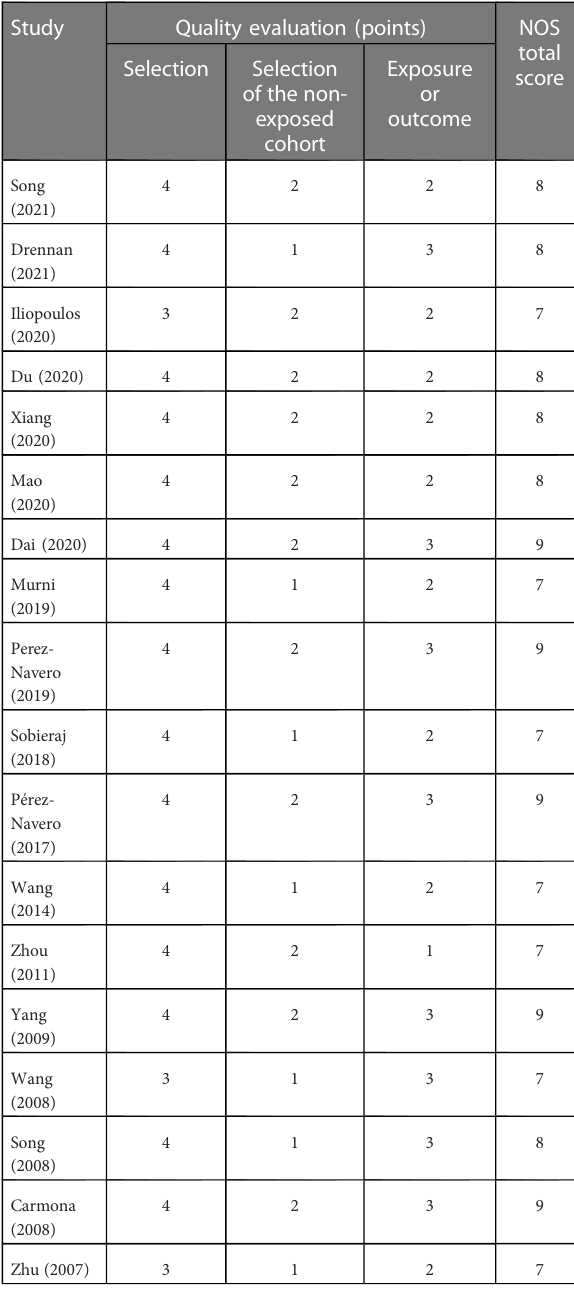
TABLE 2 Included study quality evaluation. Study